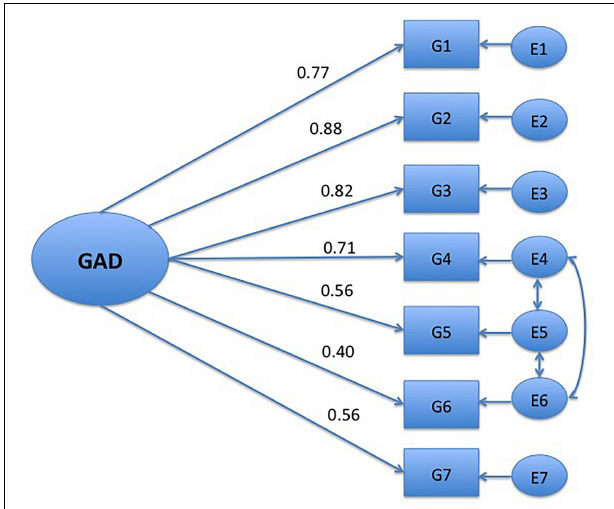
FIGURE 1 | One-factor model of the GAD-7. Only significant paths, p = 0.05 are shown. G1, nervous; G2, control of worry; G3, worry; G4, trouble relaxing; G5, restless; G6, irritable; G7,